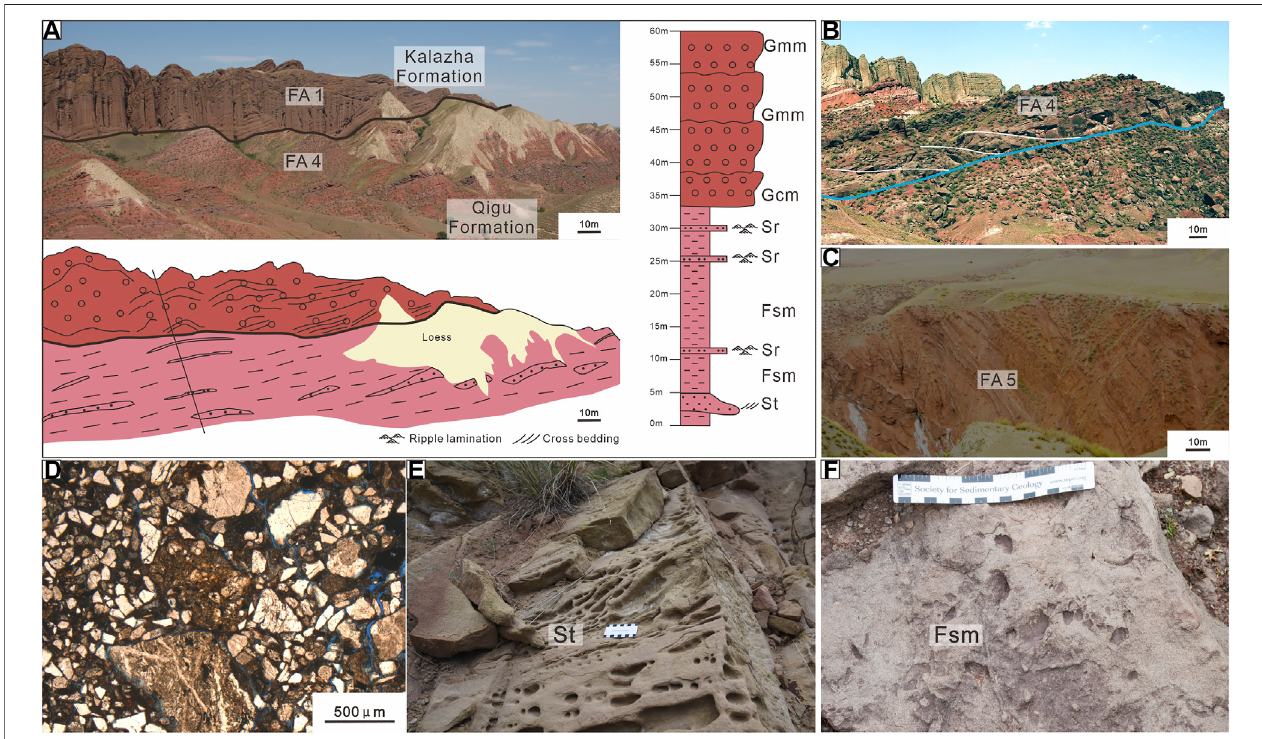
FIGURE 6 | Sedimentary characteristics of the Qigu Formation in the Southern Junggar Basin. (A) Manasi section; (B) Jiangong mine section (Guan et al., 2019); (C) HutubiRiversection; (D) castingthinsection,plane-polarizedlight,Manasisection; (E) cross-bedding,TaxiheRiversection.Mudclastswereweatheredintocavities. Therulerforscale; (F) Scoyenia ichnofacies(Guanetal.,2019),Jiangongminesection.Therulerforscale.FA-faciesassociation.Thede fi nitionoffaciesassociationssee Table 2 .